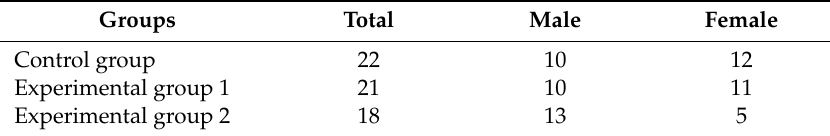
Table 1. Sample breakdown by group and